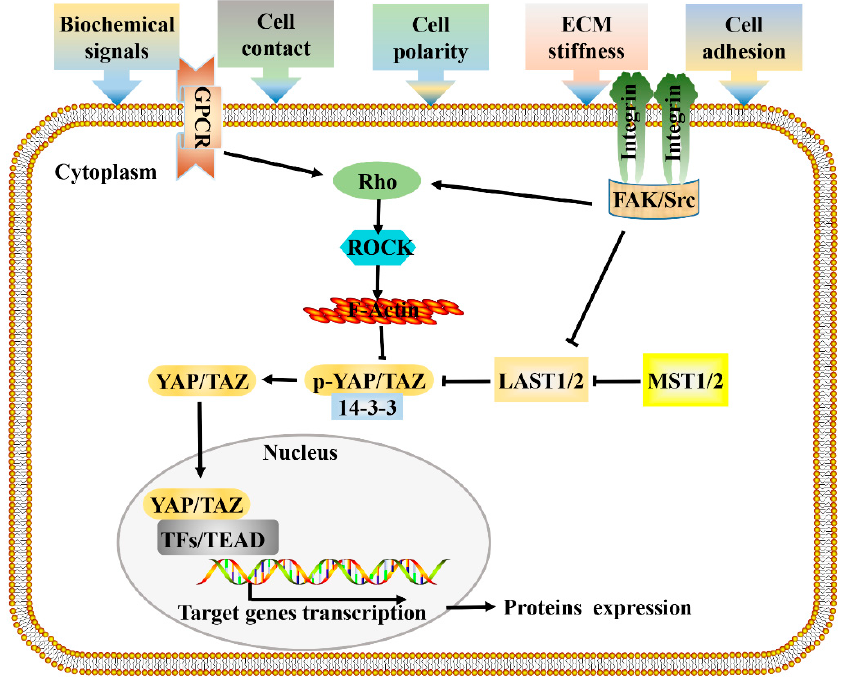
Figure 1. Signal transduction network of Hippo pathway. Cells respond to mechanical forces, cell polarity, and adhesion signals by adjusting their tensional state and actin dynamics to regulate the activity of Hippo pathway components. When a cell adheres to a larger area or grows on a harder ECM, causes the activation of integrin signaling, and promotes the assembly of FAK/Src complex, which inactivate LATS1/2 and facilitate the polymerization of F-actin cytoskeleton via Rho-GTPases, F-actin then induces the dephosphorylation and guides the nuclear translocation of YAP/TAZ. GPCR signaling responds to a variety of activators (energy, proteins, lipids, sugars), and performs the same function by acting on RHO-GTPases. Hypo-phosphorylated YAP and TAZ accumulate in the nucleus where they can bind to various TFs, most notably the TEAD family, to direct gene expression changes that control a range of biological events. Pointed and blunt arrowheads indicate activating and inhibitory interactions, respectively. FAK, Focal adhesion kinase; GPCRs, G-protein-coupled receptors; LATS, Large tumor suppressor; MST, Mammalian sterile 20 like; Src, steroid receptor coactivator; TEAD, TEA domain protein; TFs, transcription factors; YAP/TAZ, yes-associated protein/transcriptional coactivator with PDZ-binding motif.